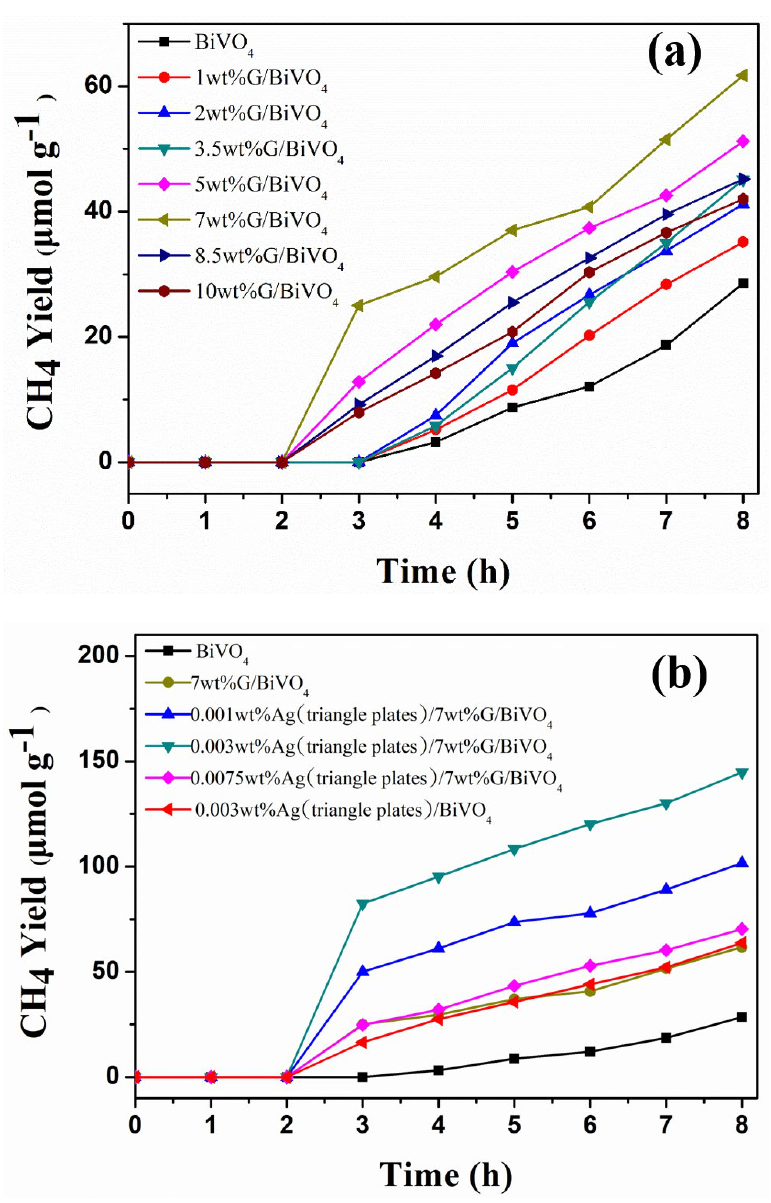
Figure 8. Production yields of CH 4 over the as-obtained photocatalysts.